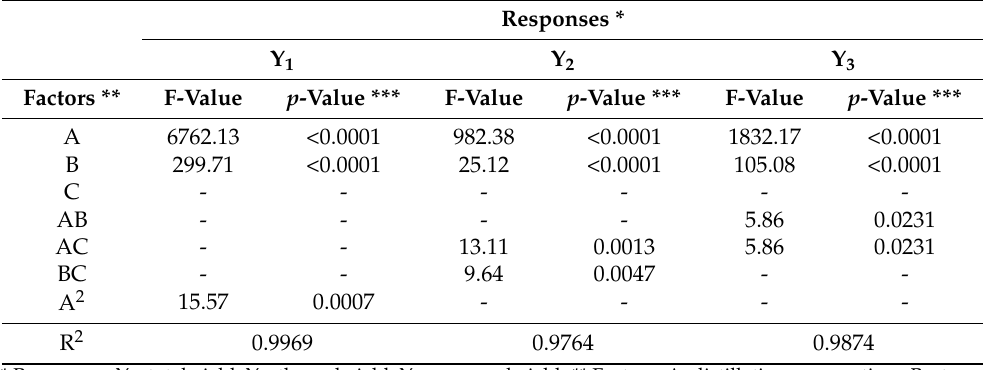
Table 3. ANOVA results for the employed CCD experimental design (insignificant factors were eliminated for convenience of